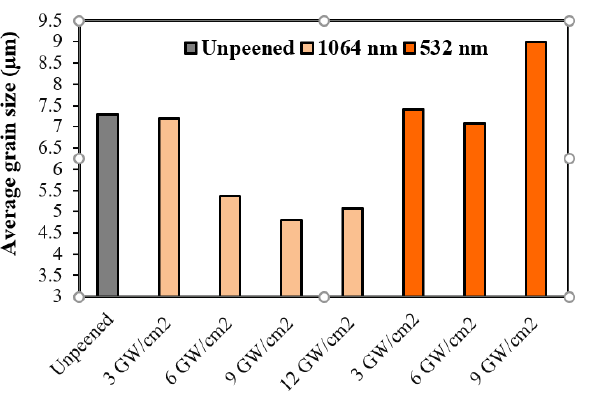
Figure 8. Average grain size distribution of microalloyed steel specimen in unpeened and LSP con- ditions.